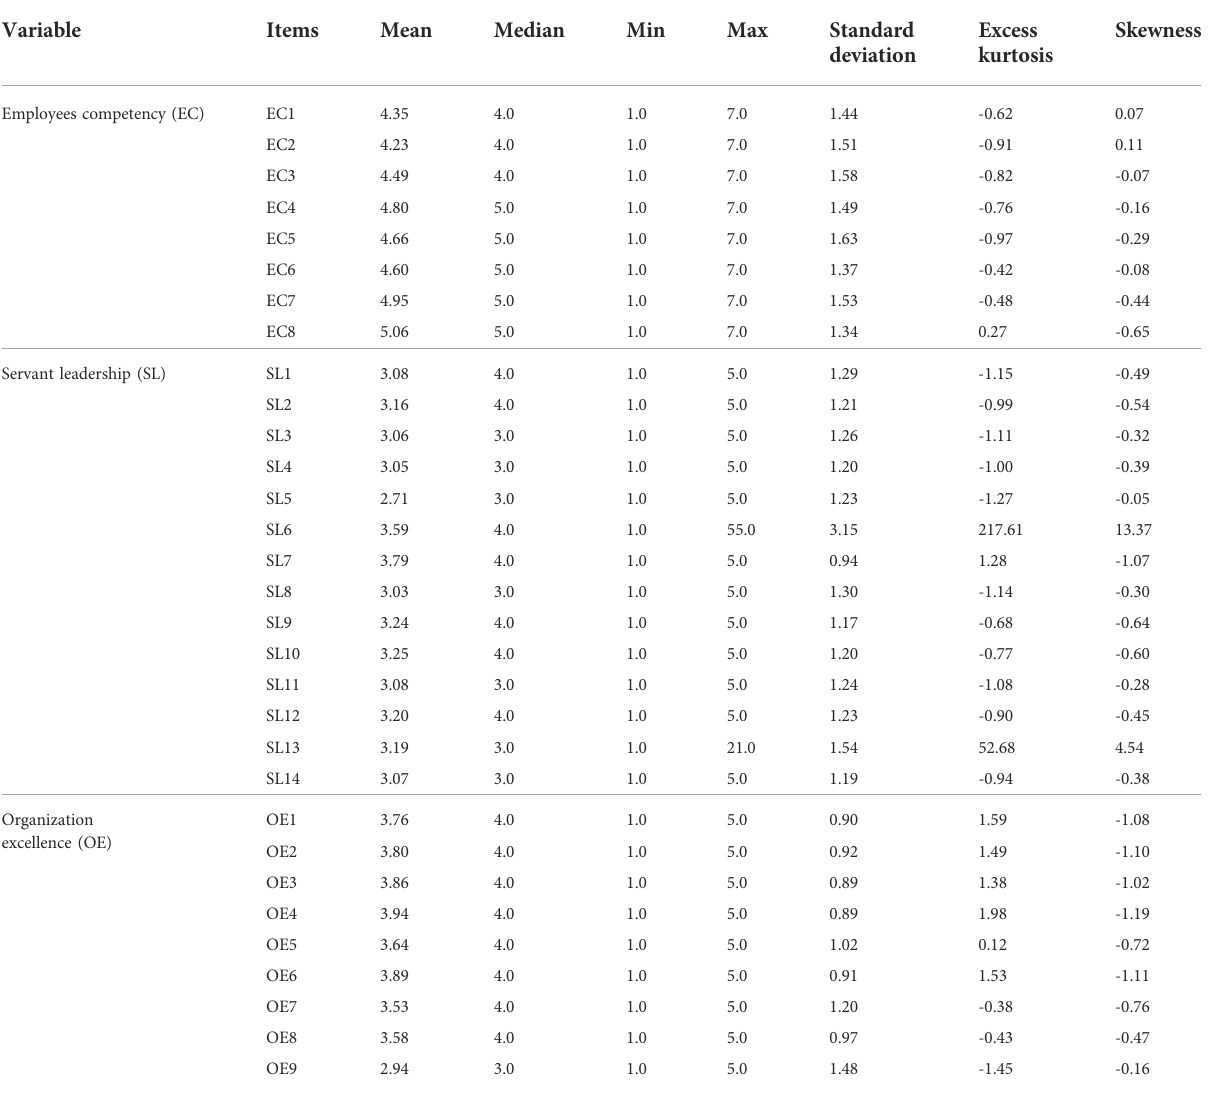
TABLE 7 MV descriptive number of observations used (n) = 329. Variable